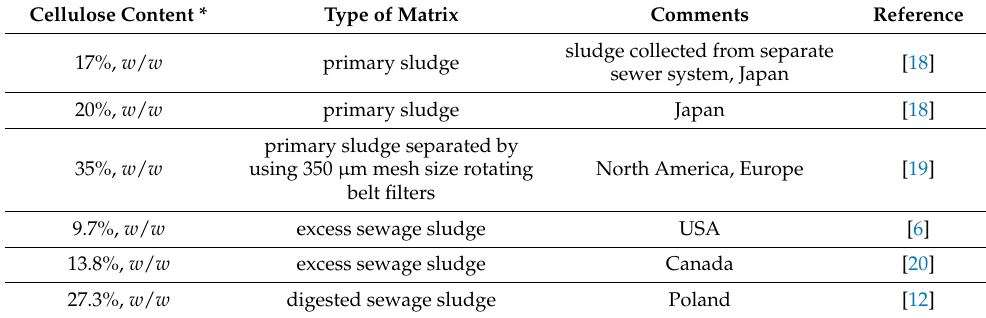
Table 1. The cellulose content in wastewater and sewage sludge according to various